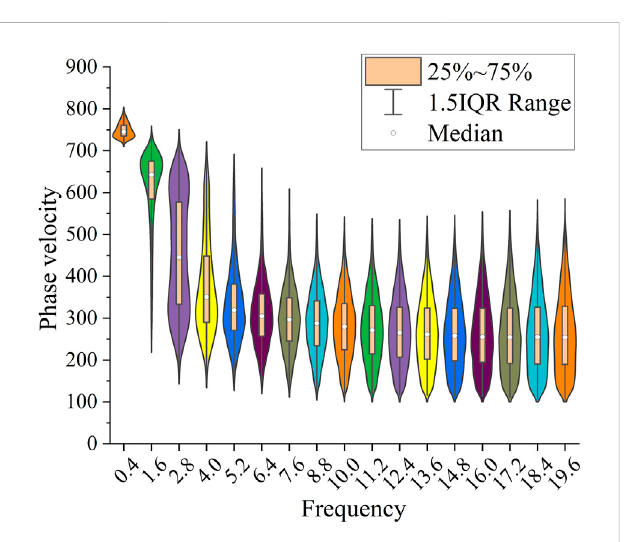
FIGURE 3 Phase velocity dispersion point violin